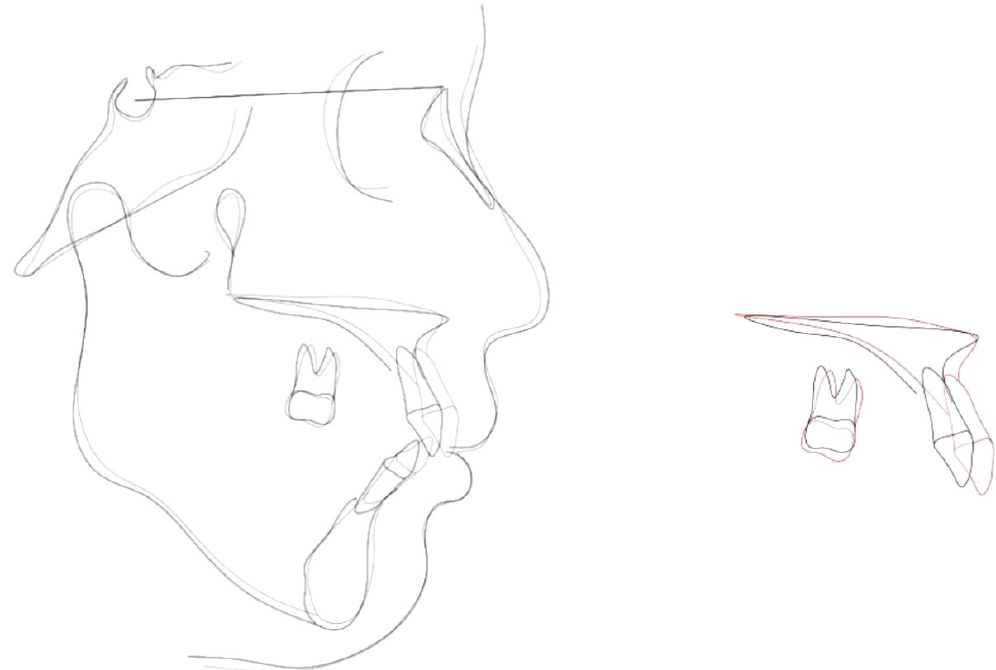
Figure 7: Superimpositions of pre- and posttreatment cephalograms showing almost constant mandibular planes, marked decrease in the upper and lower incisor inclination and upper incisor